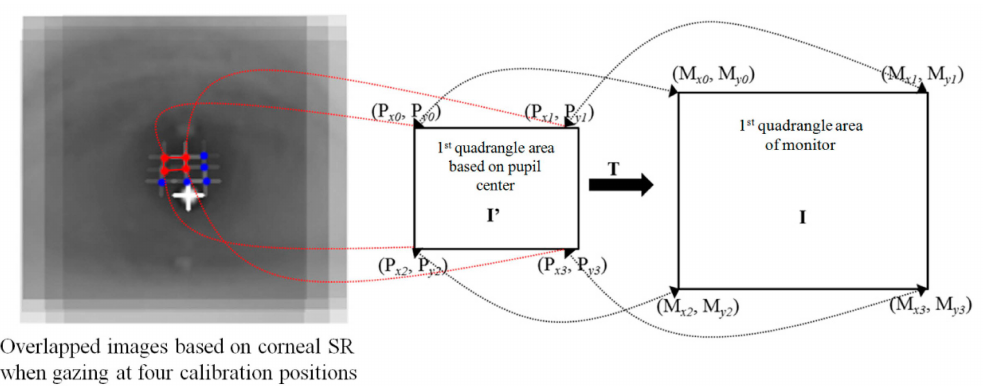
Figure 5. Example of correspondence between four pupil centers and four monitor corners when a user is gazing at the four corners of a